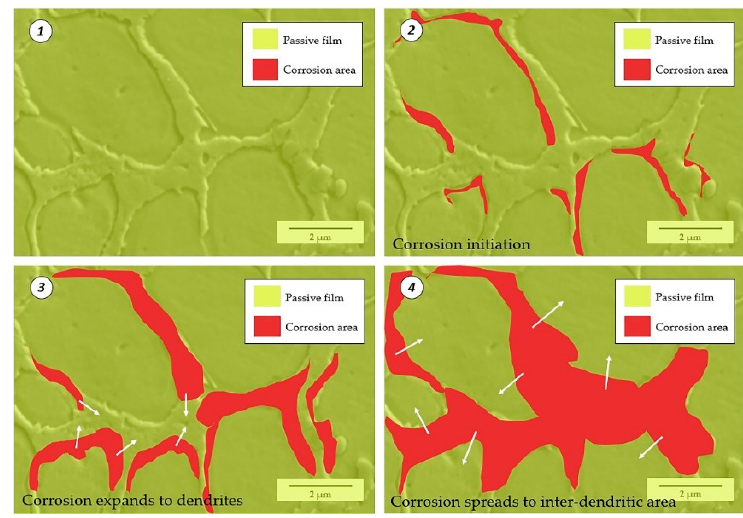
Figure 19. Schematic illustration of the corrosion expansion process.